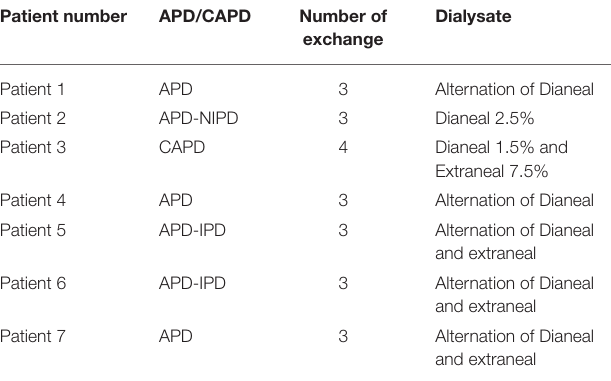
TABLE 3 | Peritoneal dialysis